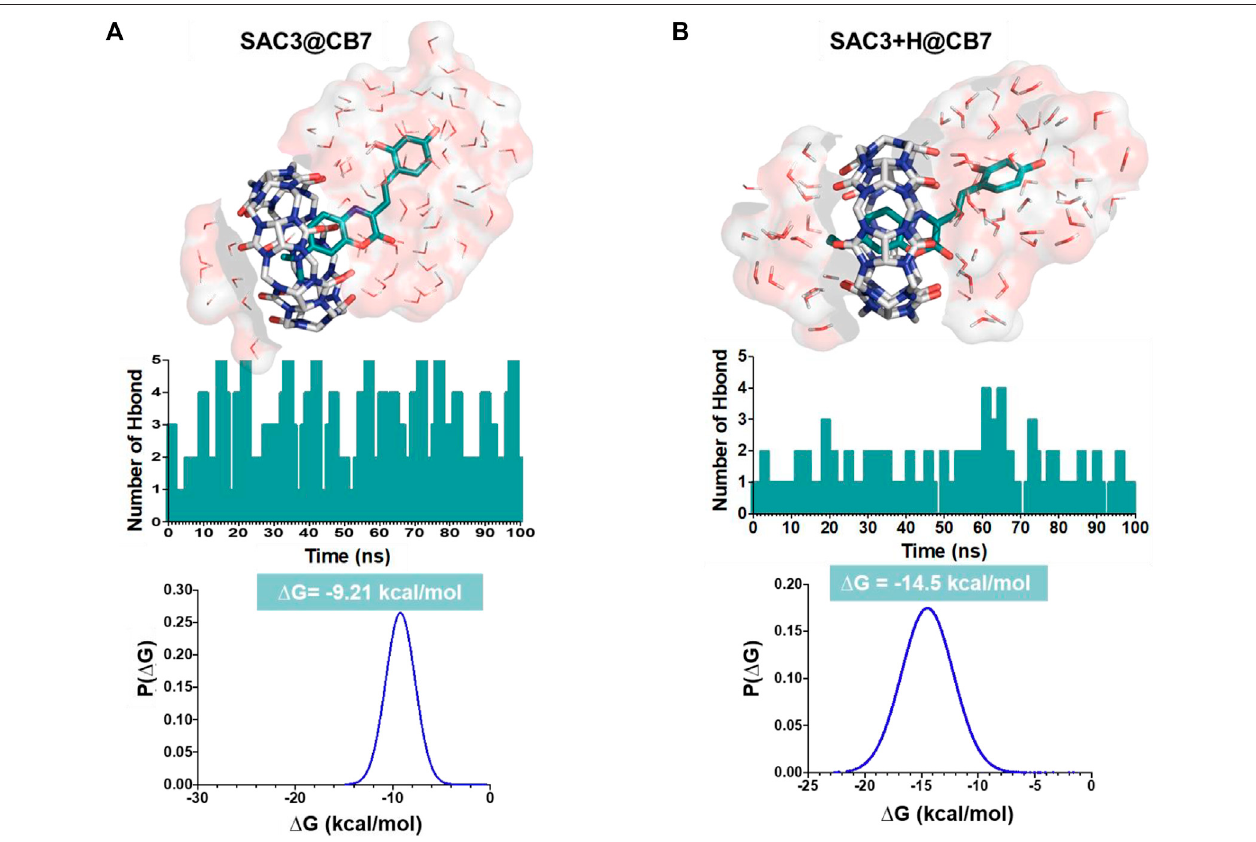
FIGURE 3 | Final conformations from molecular dynamic simulations of the CB7 containing complexes with the non-protonated form of SAC3 (A) and the protonatedform(onthedialkylaminonitrogen)of SAC3(B) .Inthemiddlepanel,histogramsofthenumberofhydrogenbondsduringthesimulationaredisplayed.Onthe bottom panel, a free energy distribution from MM/PBSA calculations is shown.